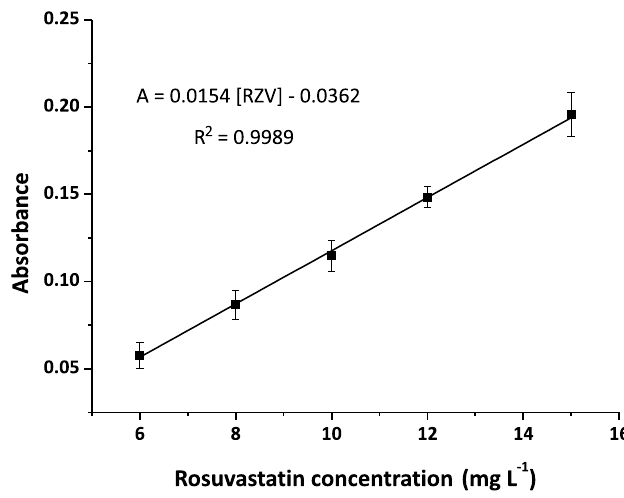
FIGURE 7 - Analytical curve for the determination of rosuvastin using the charge transfer reaction. Experimental conditions: quinalizarin: 40 mg L -1 ; rosuvastatin: 20 mg L -1 and DMSO 75%